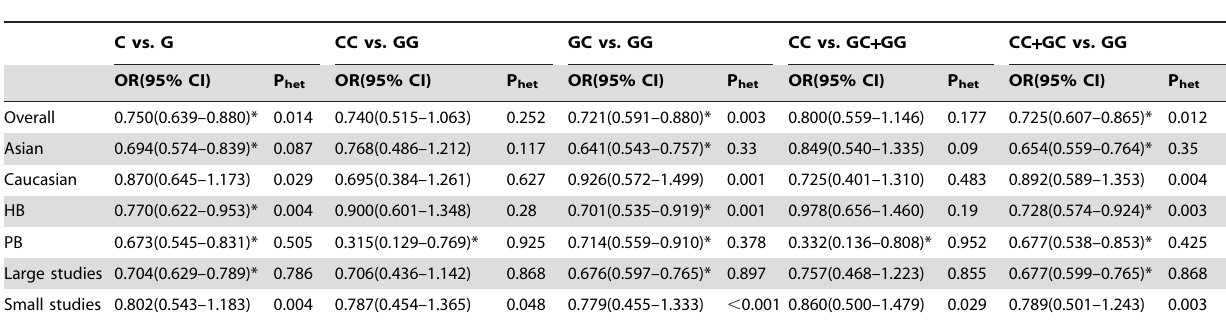
Table 2. Meta-analysis results estimated by genotype distribution